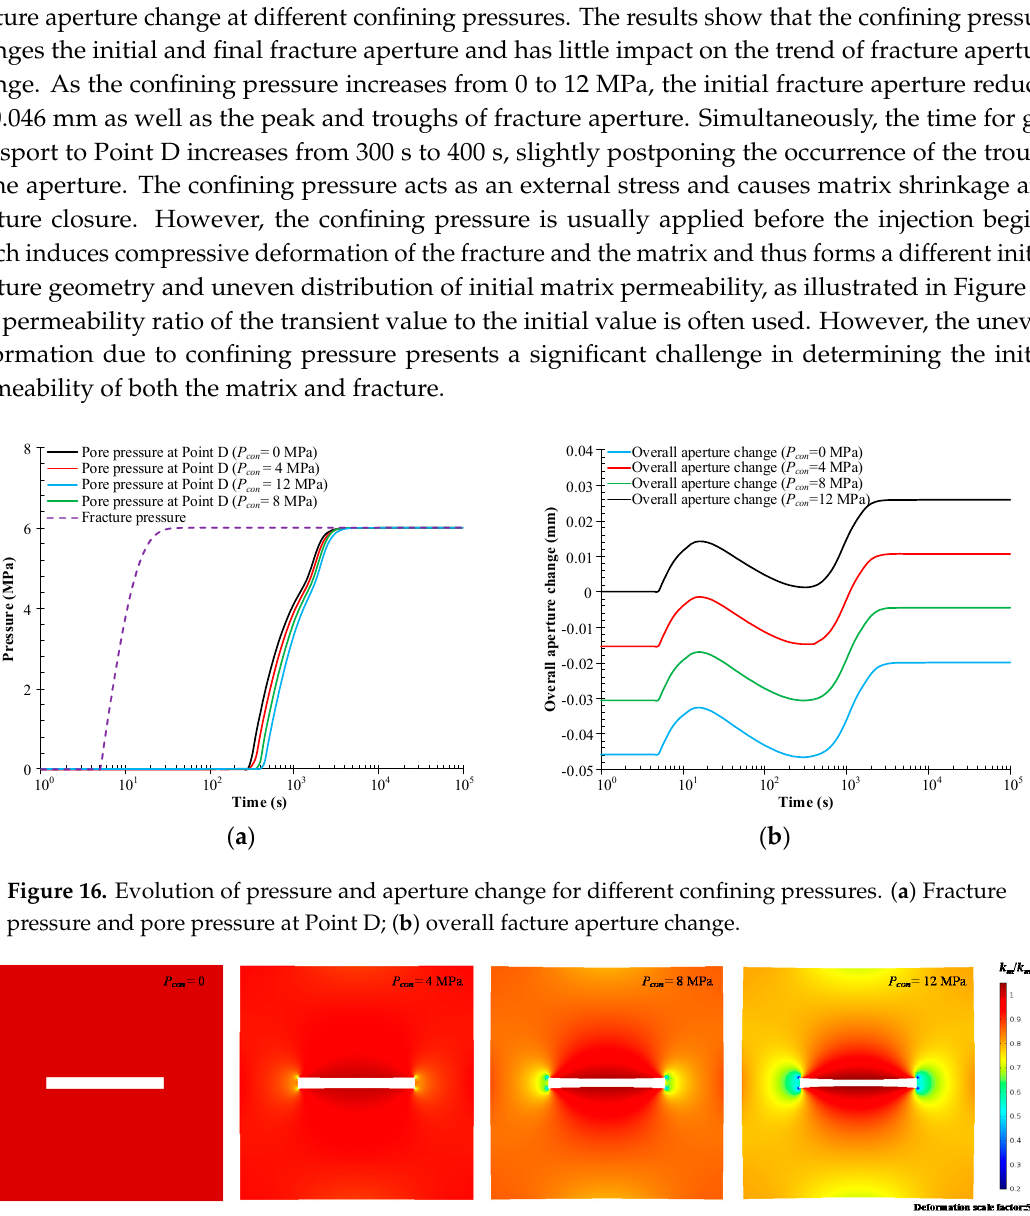
Figure 17. Uneven deformation and permeability ratio in the matrix induced by different confining pressures.